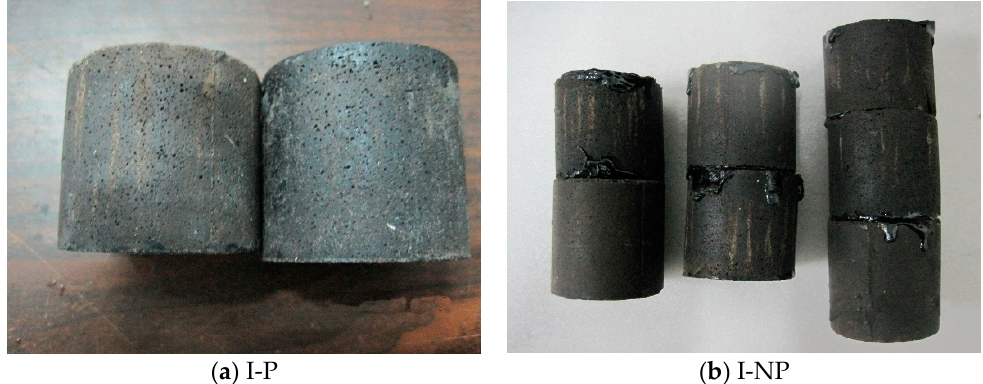
Figure 7. Effect of the polymer emulsion addition on the oozing of the asphalt in the hardened CA mortar during the fatigue test. ( a ) the CA mortar with polymer emulsion incorporation and ( b ) the CA mortar without polymer emulsion.